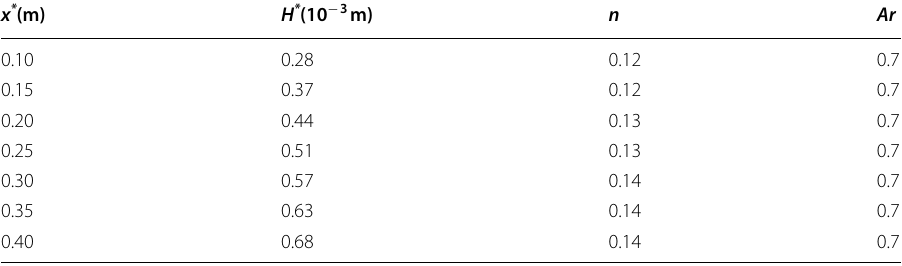
Table 1 Optimal geometric parameters along the streamwise